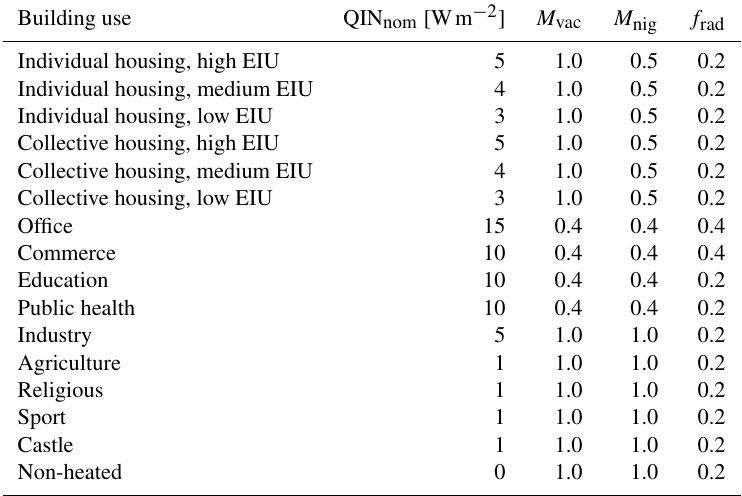
Table A4. Nominative value of the internal heat release (QIN nom ), modulation factor for periods when the building is vacant ( M vac ) and during the night ( M nig ) and radiative part of internal heat releases ( f rad ). For the residential buildings, the values for QIN nom are based on the ENERGIHAB and ENL surveys for the three classes of the equipment-intensity-of-use (EIU) indicator. Building use QIN nom [ Wm − 2